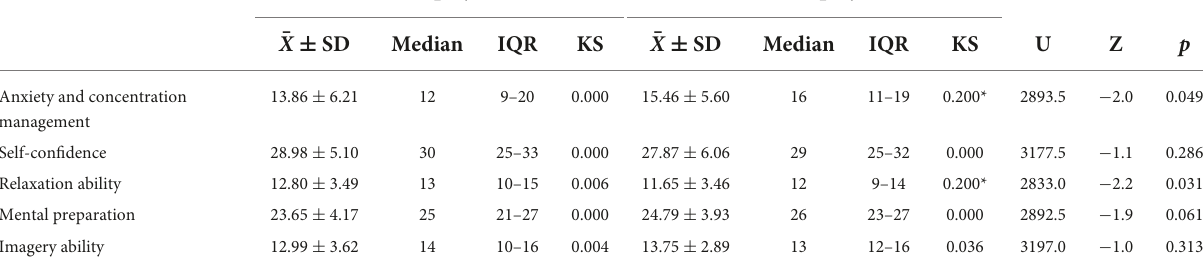
TABLE 5 Gender differences in mental